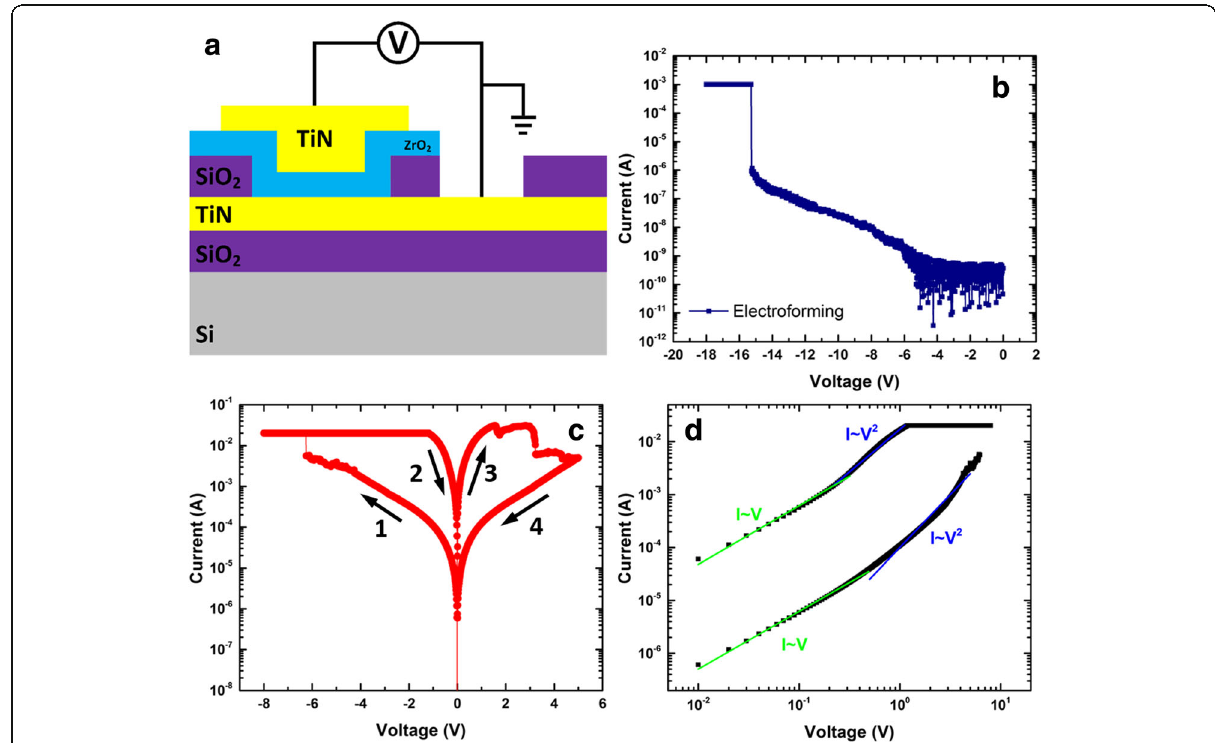
Fig. 6 a Schematic of the single layer TiN/ZrO 2 /TiN device. b I – V characteristics of the electroforming process for the TiN/ZrO 2 /TiN device. c I – V characteristics of the TiN/ZrO 2 /TiN device after forming. d I – V curves of the SET process in double-logarithmic plot with linear